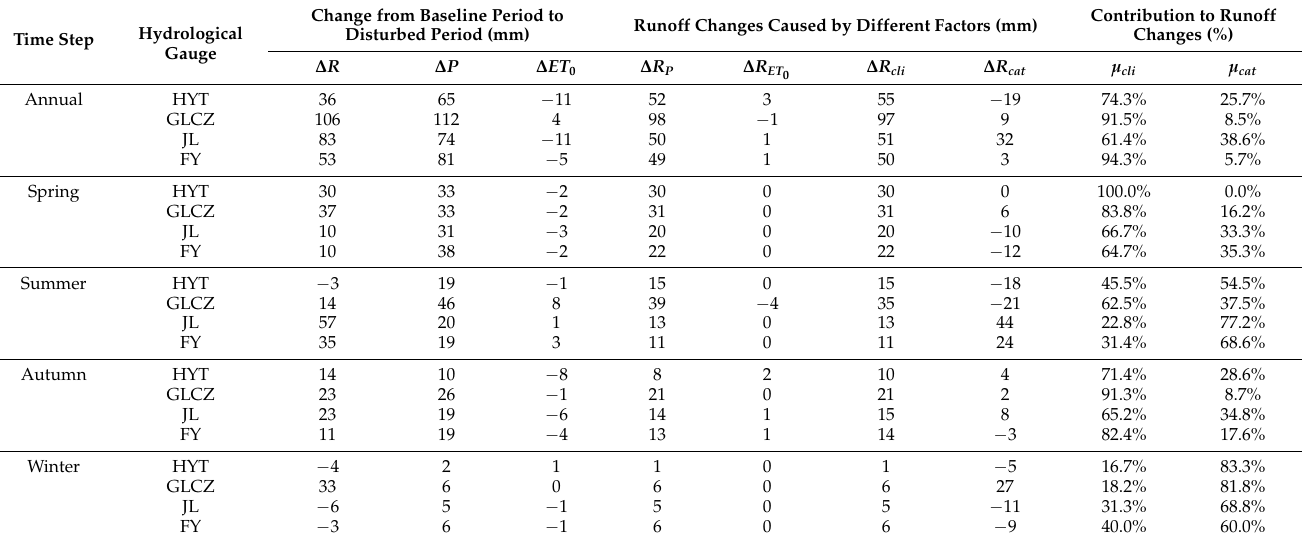
Table 4. Results of attribution analysis of runoff changes in the SSR